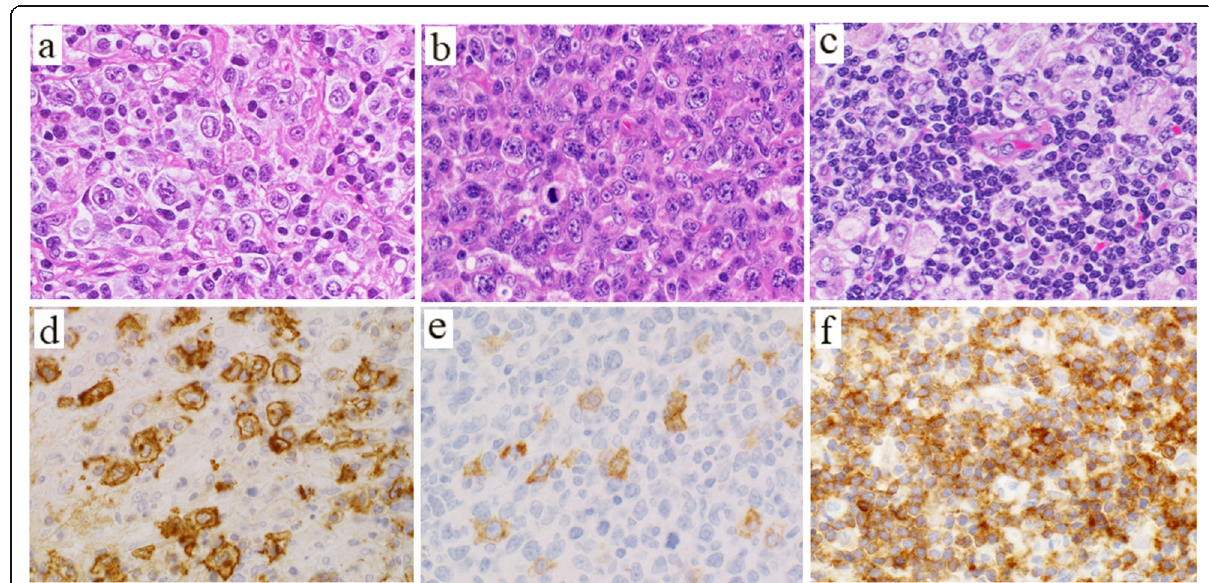
Fig. 1 Histological findings and immunohistology in patients with large and small cell PTCL-TFH. Many atypical large lymphocytes are distributed throughout ( a, b ), and small lymphocytes and histiocytes are intermingled in the background ( a ). c Diffuse infiltrate of small lymphocytes and nests of epithelioid histiocytes, indicating Lennert lymphoma. d Scattered large atypical lymphocytes are positive for CD30, and ( e ) only some CD30+ cells can be seen. f Diffuse infiltration of PD-1+ small lymphocytes in Lennert lymphoma. Magnification, × 400